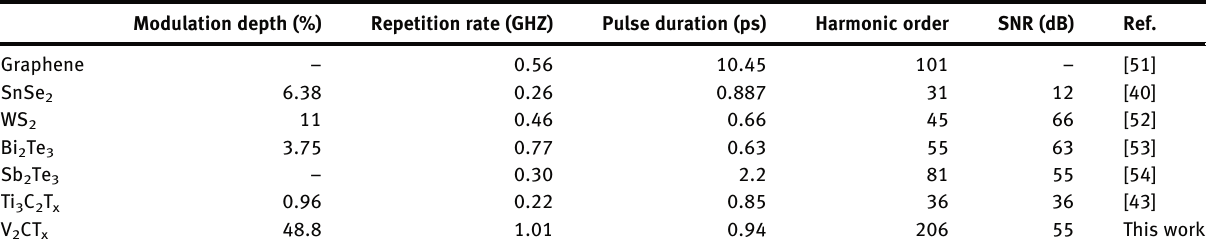
Table  : Comparison of output performance of  .  µm harmonic mode-locked fi ber lasers based on  D materials. Modulation depth (%) Repetition rate